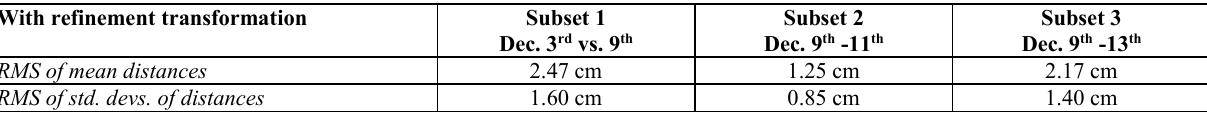
Table 5. RMSs and std. devs. of the distances between representative points in corresponding blocks and various subsets after the application of a refinement transformation to mitigate possible systematic errors.